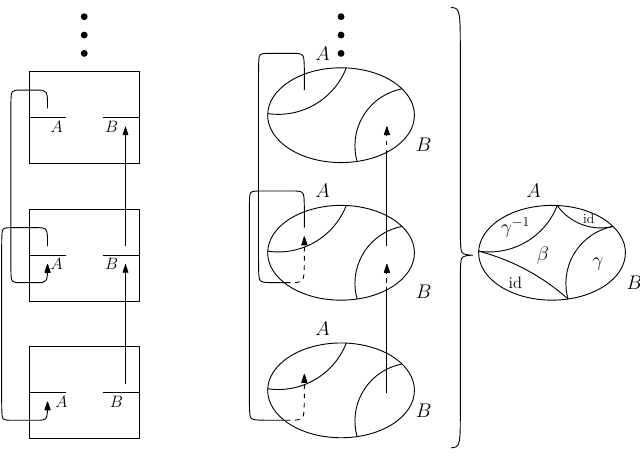
Figure 33 . Branched surfaces for the negativity